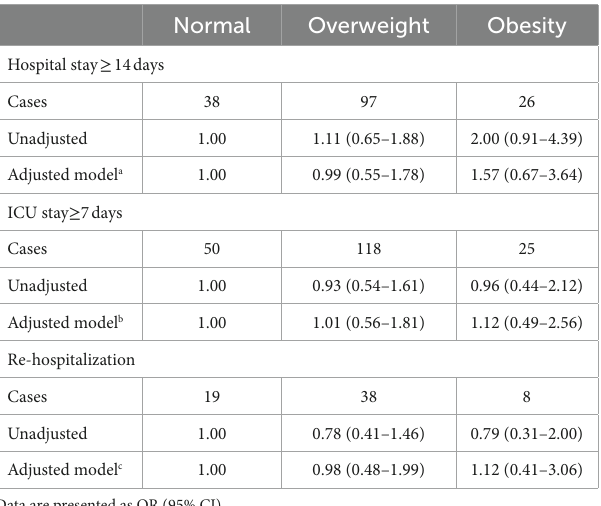
TABLE 4 Odds ratios for re-hospitalization and prolonged stay in ICU and hospital across categories of BMI in critically ill elderly patients with